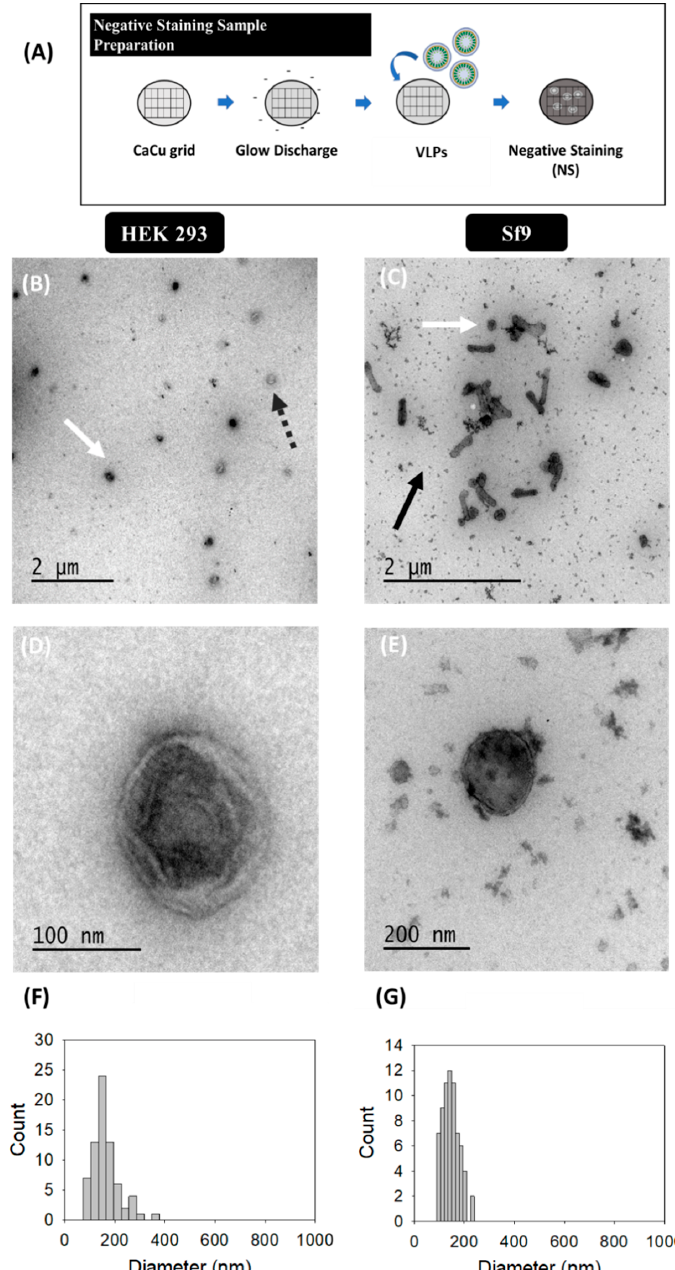
Figure 1. Transmission electron microscopy with negative staining analysis of HIV-1 Gag-eGFP VLPs produced in HEK 293 and Sf9 cells harvested at 72 hpt and 72 hpi, respectively. ( A ) Sample preparation protocol; ( B – E ) samples corresponding to the 25–45% ultracentrifugation fraction from HEK 293 supernatants ( B , D ) and Sf9 supernatants ( C , E ). All samples were stained with uranyl acetate